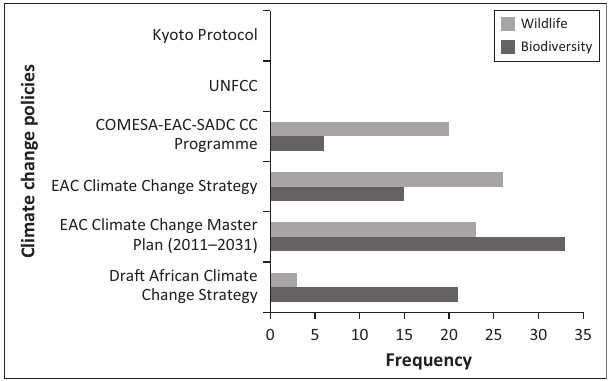
FIGURE 3: Frequency counts for ‘wildlife’ and ‘biodiversity’ in international and regional climate change policies.